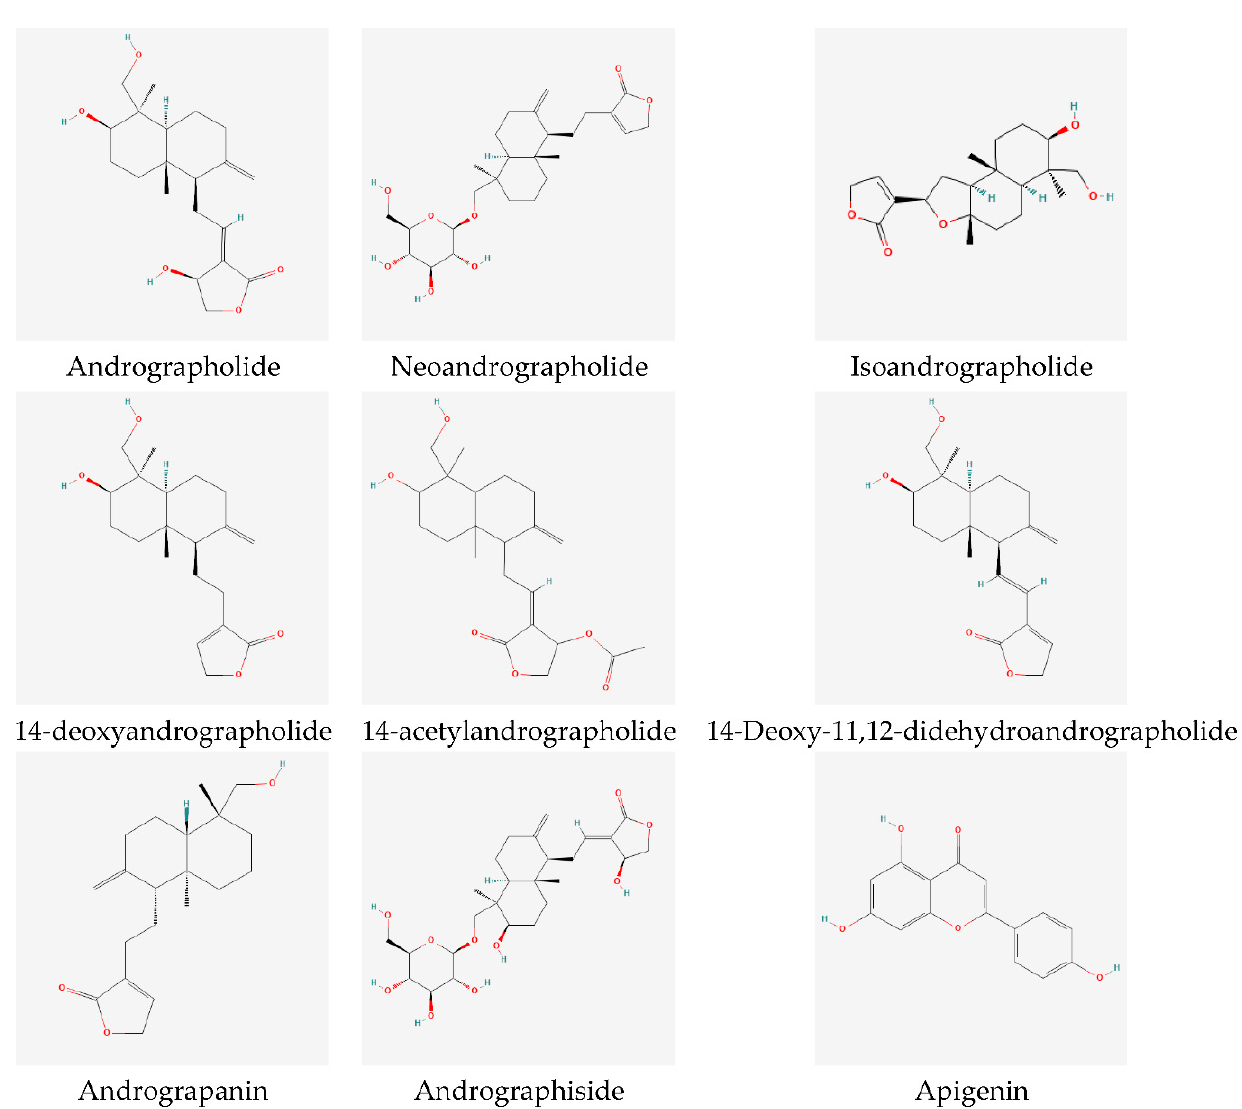
Figure 3. Chemical structures of active components in A. paniculata [16,18,20].